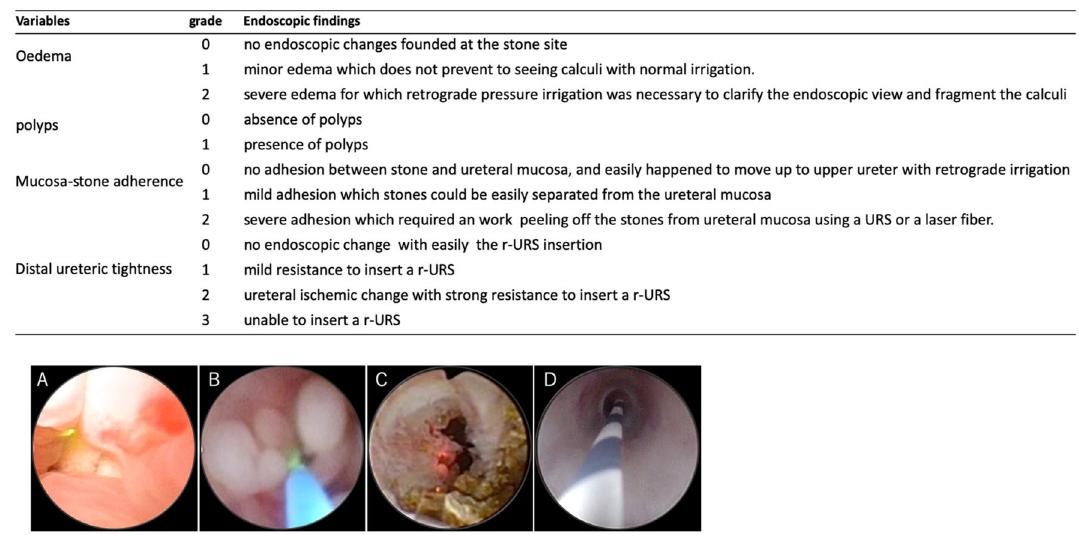
Figure 3. SMART classification of endoscopic findings and endoscopic views of ureteral changes (grade 2 oedema, polyps, mucosa-stone adherence (MSA), distal ureteric tightness (DUT)). Endoscopic views of ureteral changes are shown in ( A )–( D ). ( A ) grade 2 oedema, ( B ) grade 1 polyps, ( C ) grade 2 MSA, ( D ) grade 2